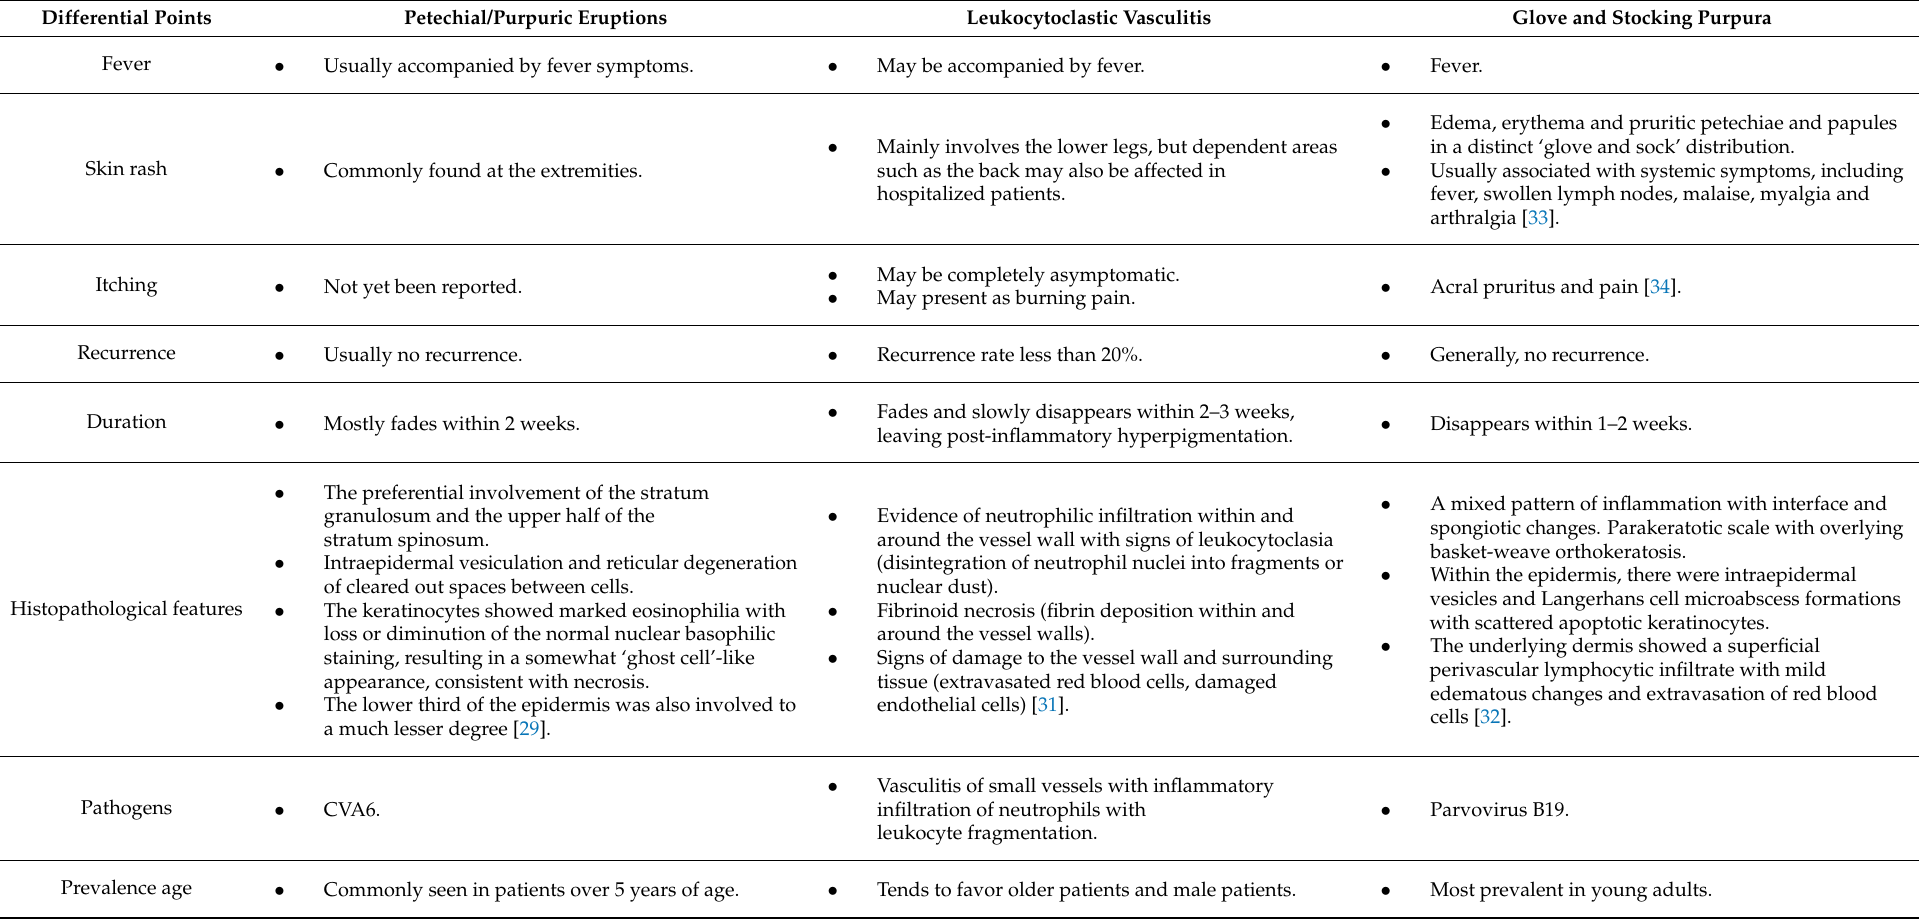
Table 3. Differential diagnosis of petechial/purpuric